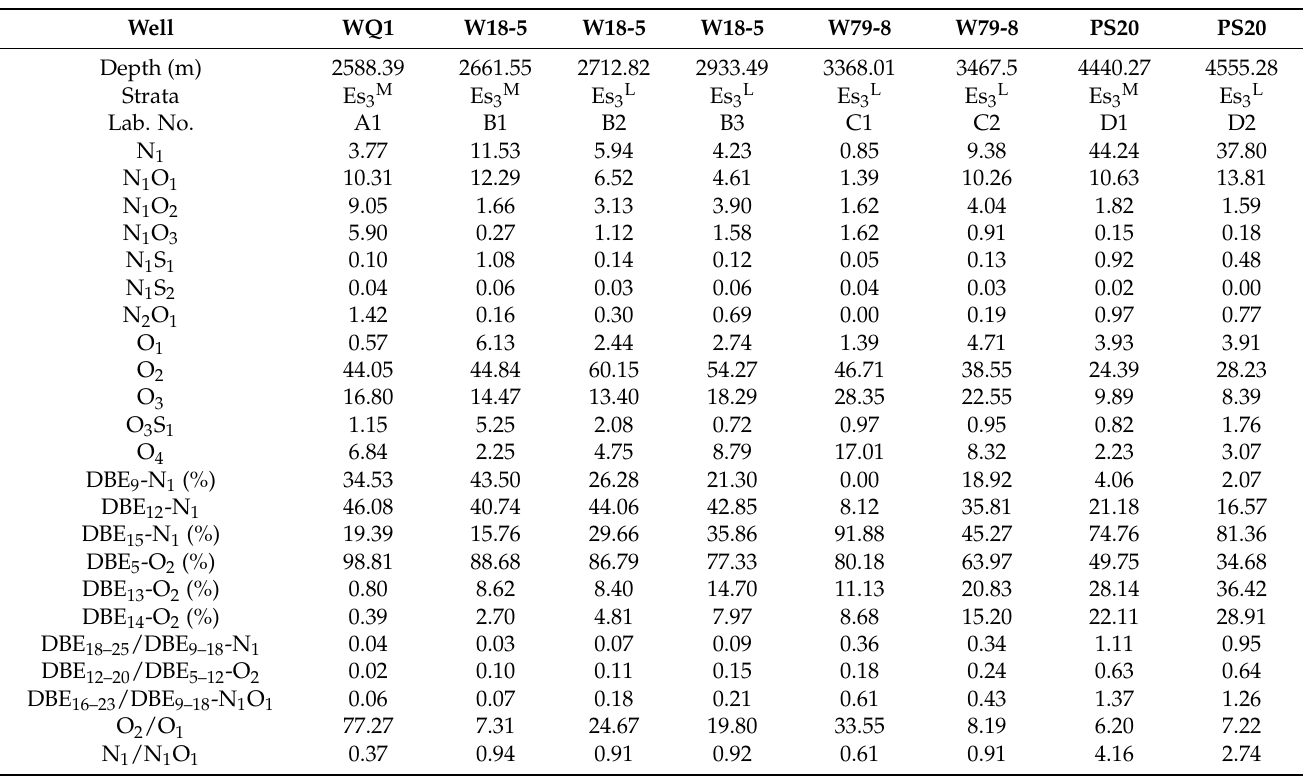
Figure 6. Distribution of the mudstone compound types in the Dongpu Depression as determined by negative ion high resolution mass spectrometry. Table 2. The basic parameters of the source rock and oil sands extracts that were analyzed by negative-ion ESI FT-ICR MS.